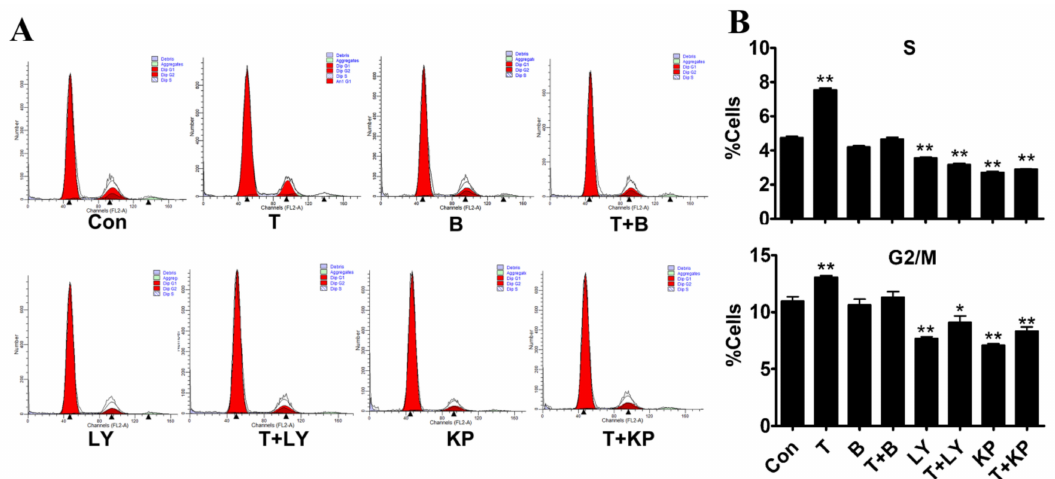
Figure 5. E ff ect of T and inhibitors treatment on cell cycle of myoblasts cultured in vitro. ( A–B ): Cell cycle of myoblasts treated with T and / or inhibitors (Bicalutamide, B; LY294002, LY; KP372-1, KP) was detected by flow cytometry. The percentage of S or G2 / M stage cells was measured in di ff erent treatment compared with control (Con). A minimum of 15,000 myoblast cells were analysed for each sample. Values are means + SE of four independent experiments with triplicate determinations. Asterisk (*) represents statistically di ff erent ( p < 0.05), ** indicates that the di ff erence is extremely significant ( p < 0.01).